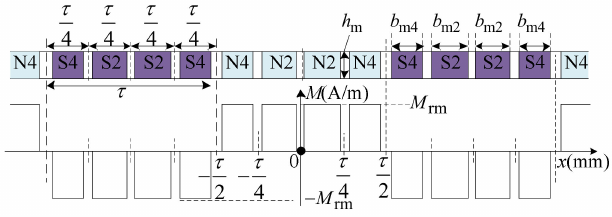
Figure 5. Structure of Array I with s = 4.